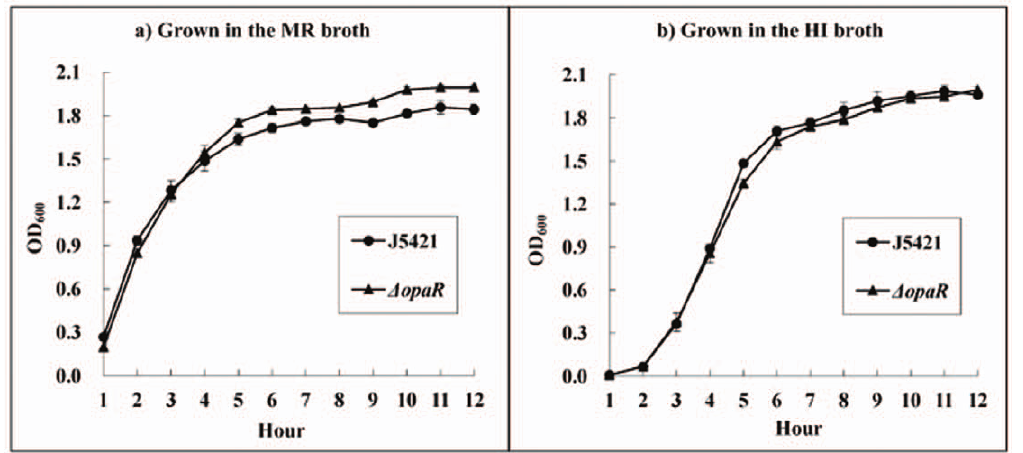
Figure 4. Growth curves. A two-round design of bacterial seed cultivation was employed: first, the glyceric stock of bacteria was inoculated into 15 ml of the MR or HI broth for growing at 30 u C for 24 h with shaking at 200 rpm, and the cell culture was subsequently diluted to an OD 600 value of about 1.0; second, the resulting culture was then 50-fold diluted into 15 ml of corresponding fresh MR or HI broth, and allowed to grow to reach an OD 600 value of about 1.2 to 1.4. The bacterial seeds were 50-fold diluted into 15 ml of corresponding fresh MR or HI broth for further cultivation, and the OD 600 values were monitored for each culture with a 1 h interval. Experiments were done in triplicate.